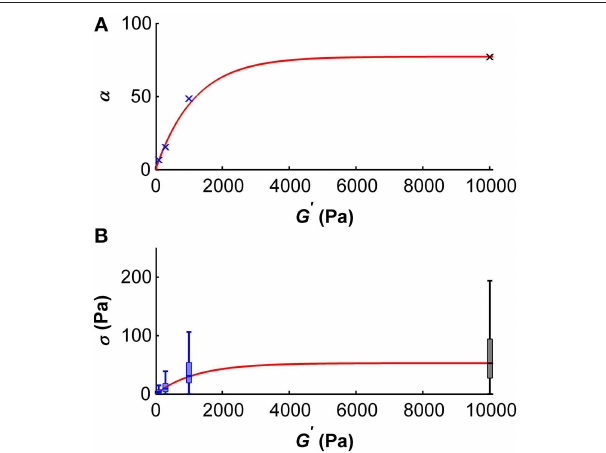
FIGURE 8 | Dependency of the scale parameter α (A) and the traction stress σ (B) on the gel’s shear modulus G ′ . (A) Blue crosses represent α values determined for G ′ ∼ 100, ∼ 300, and ∼ 1000 Pa, the black cross represents an α value approximated for G ′ ∼ 10 kPa using the master curve and the constant peak stress to standard deviation ratio. An initial regime of fast increase of α (which scales proportionally with the median traction stress) was observed for shear moduli below ∼ 2 kPa. The red curve represents the best fit with an adjusted R 2 -value of 0.99. (B) Boxplots of the traction stresses σ for G ′ ∼ 100, ∼ 300, and ∼ 1000 Pa are shown in blue. Black boxplot shows the estimated traction stress σ for G ′ ∼ 10 kPa. An initial regime of fast increase of σ was observed for shear moduli below ∼ 2 kPa. The red curve represents the best fit through the median traction stresses with an adjusted R 2 value of